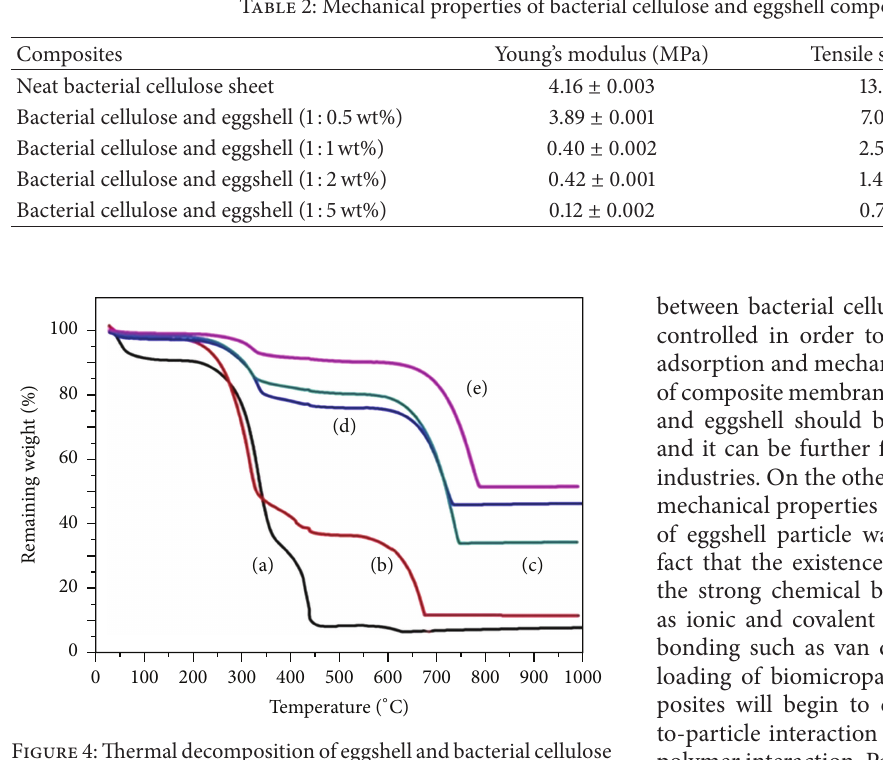
Figure 4: Thermal decomposition of eggshell and bacterial cellulose composite membrane. (a) Neat bacterial cellulose. (b) 1:0.5 weight ratio of bacterial cellulose and eggshell. (c) 1: 1 weight ratio of bacterial cellulose and eggshell. (d) 1: 2 weight ratio of bacterial cellulose and eggshell. (e) 1 :5 weight ratio of bacterial cellulose and